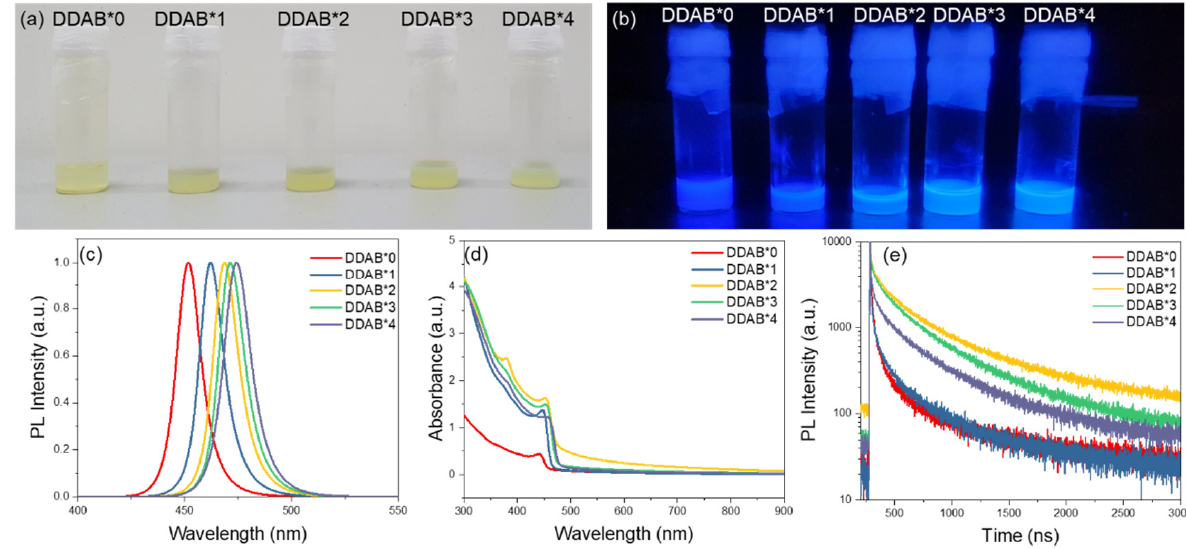
Figure 1. Photo images under ( a ) ambient light and ( b ) UV light of 365 nm; ( c ) PL, ( d ) absorption and ( e ) TRPL spectra of CsPbCl x Br 3−x PQDs with different DDAB concentrations.